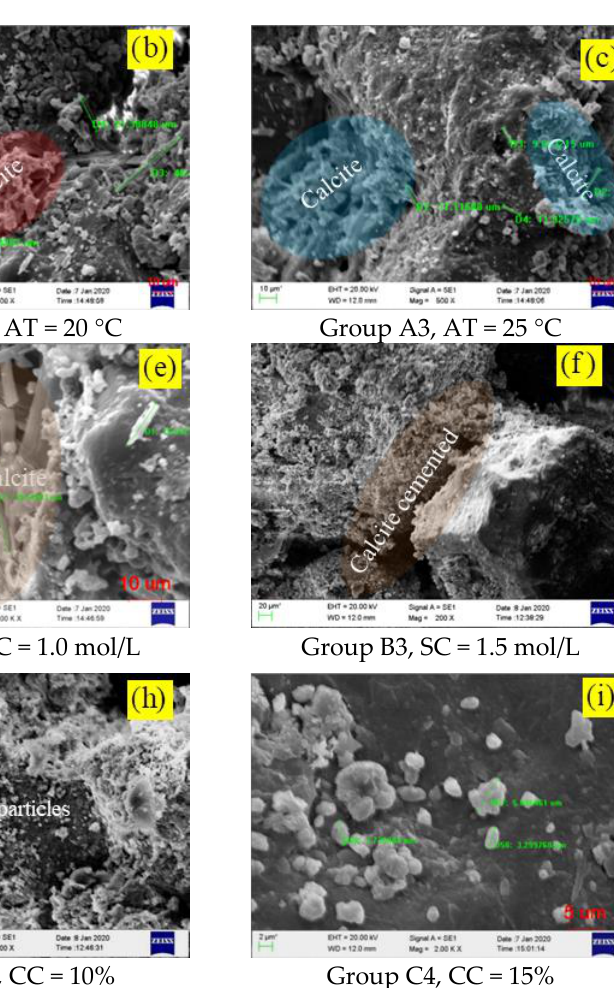
Figure 10. SEM – EDS analysis. ( a ) T = 15 ℃ , ( b ) SC = 0.5 mol/L